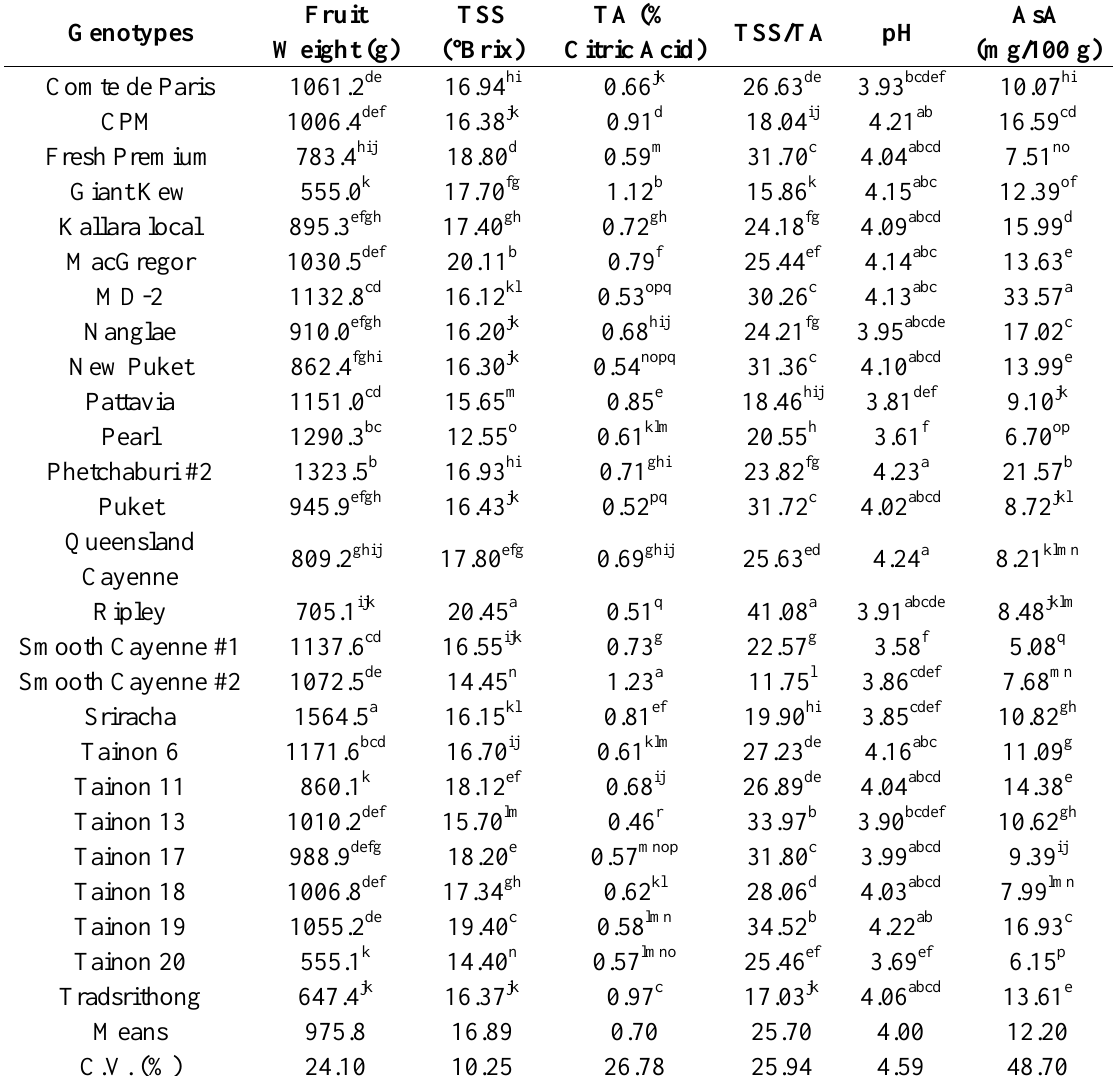
Table 1. Fruit weight, total soluble solids (TSS), titratable acidity (TA), TSS/TA ratio, pH, and ascorbic acid (AsA) of 26 pineapple genotypes from